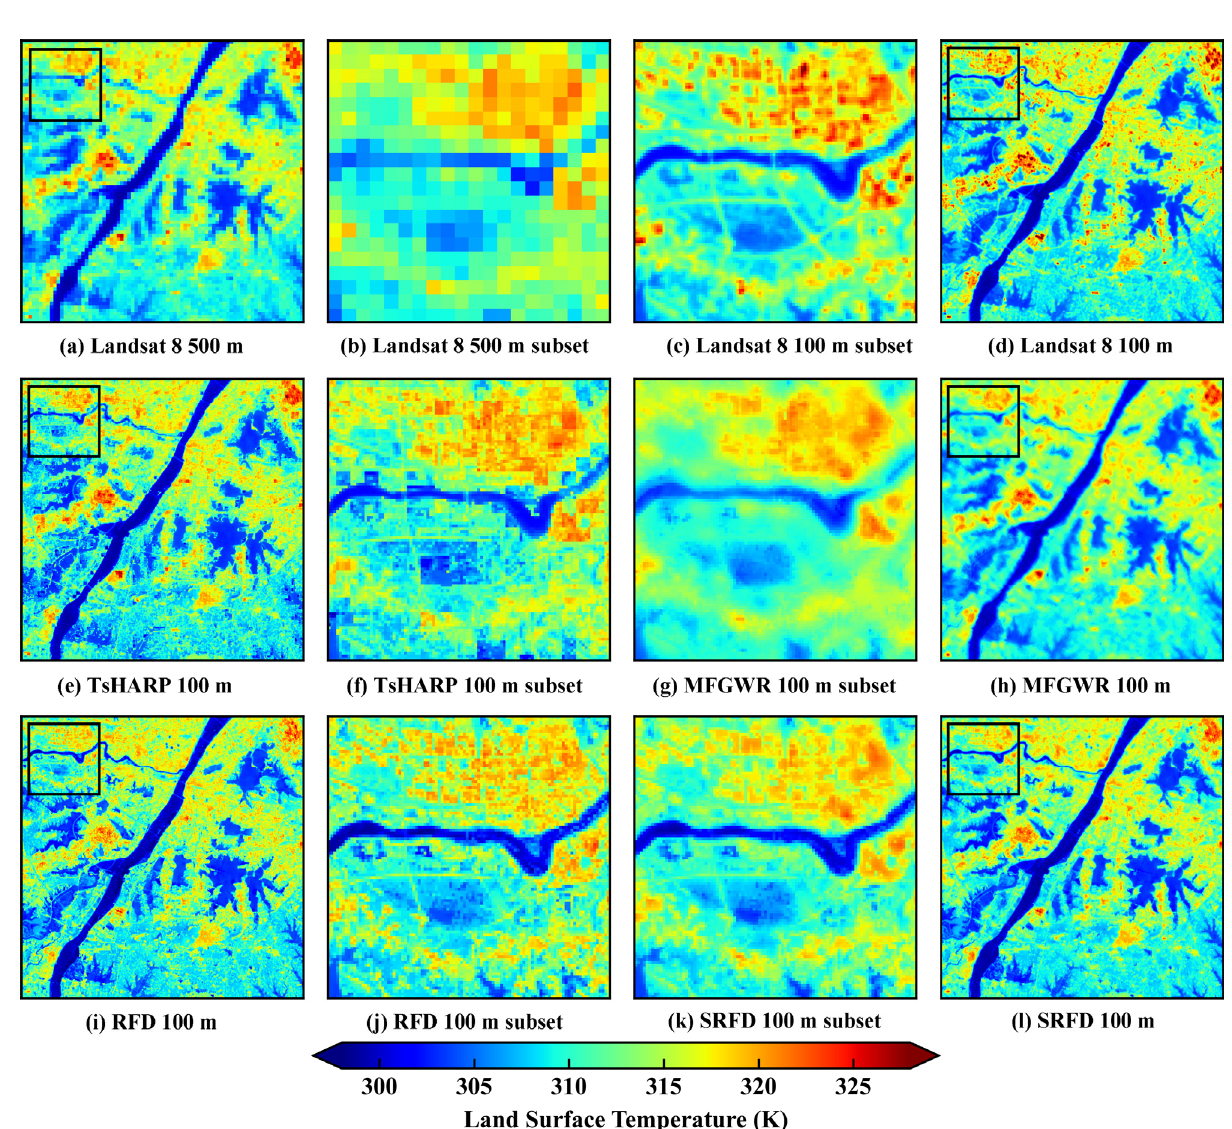
Figure 6. Visual comparison of different downscaling methods in image W1. ( a ) Landsat 8 LST (500-m). ( b ) Subset of Landsat 8 LST (500-m). ( c ) Subset of Landsat 8 LST (100-m). ( d ) Landsat 8 LST (100-m). ( e ) TsHARP downscaled LST (100-m). ( f ) Subset of TsHARP downscaled LST (100-m). ( g ) Subset of MFGWR downscaled LST (100-m). ( h ) MFGWR downscaled LST (100-m). ( i ) RFD downscaled LST (100-m). ( j ) Subset of RFD downscaled LST (100-m). ( k ) Subset of SRFD downscaled LST (100-m). ( l ) Subset of SRFD downscaled LST (100-m).